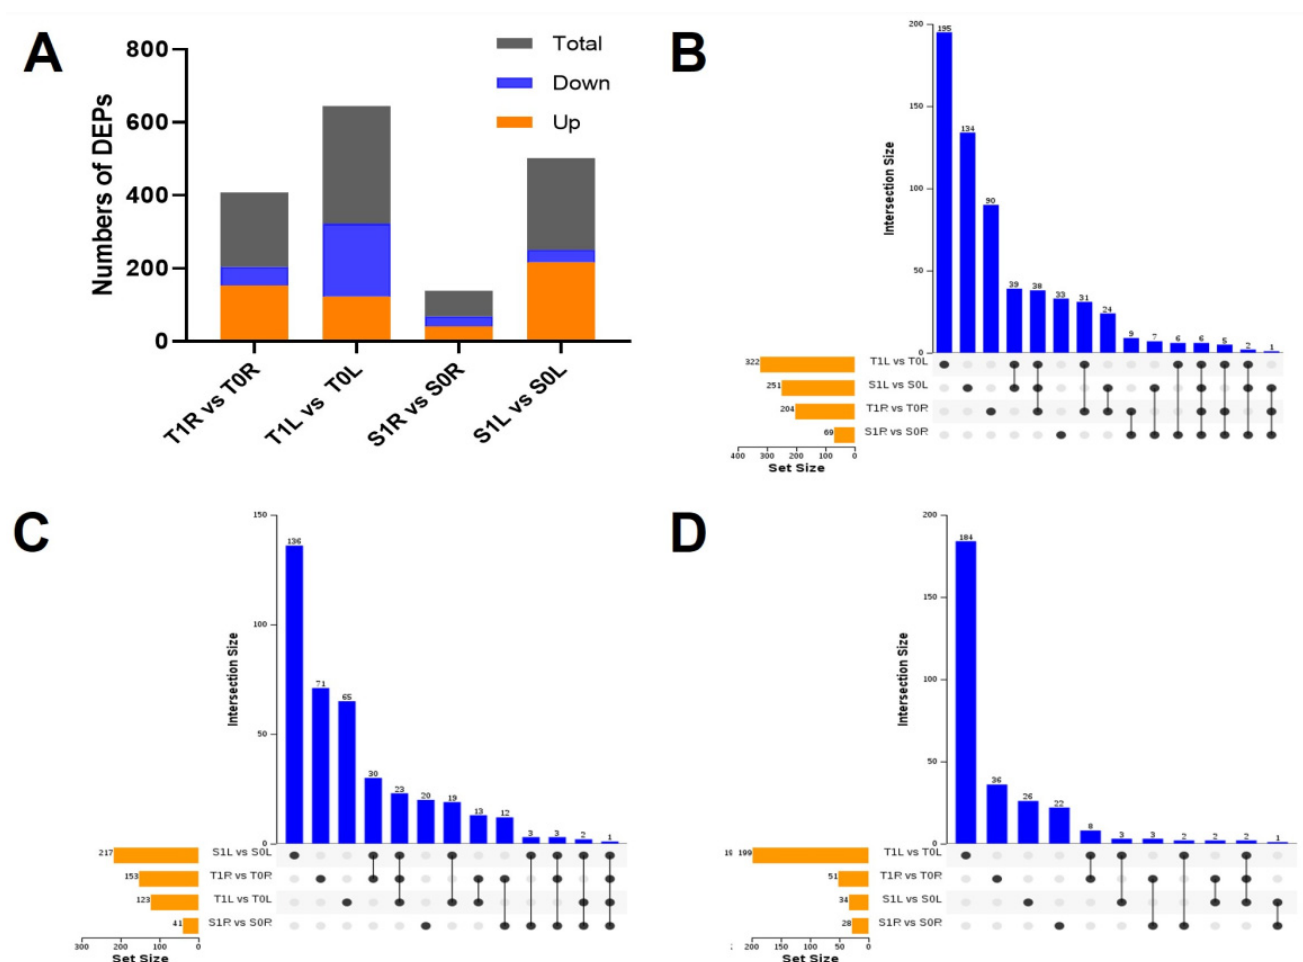
Figure 3. Analysis of DEPs in the roots and leaves of Tieguanyin and Shuixian under La treatment and UpSet Venn diagram. ( A ) DEP numbers in roots and leaves of Tieguanyin and Shuixian under La treatment. ( B ) UpSet Venn diagram of DEPs in the compared group. ( C ) UpSet Venn diagram of upregulated expressed proteins in the compared group. ( D ) UpSet Venn diagram of downregulated expressed proteins in the compared group. T0L, Tieguanyin leaf under the control treatment; T1L, Tieguanyin leaf treated with 1.2 mmol/L La; S0L, Shuixian leaf under the control treatment; S1L, Shuixian leaf treated with 1.2 mmol/L La; T0R, Tieguanyin roots under the control treatment; T1R, Tieguanyin roots treated with 1.2 mmol/L La; S0R, Shuixian roots under the control treatment; S1R, Shuixian roots treated with 1.2 mmol/L